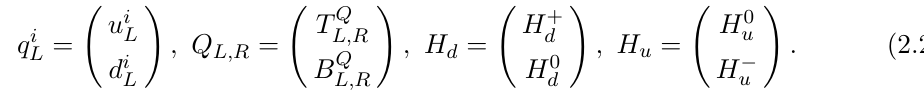
further assume that quarks couple to the two Higgs doublets as in the type-II model, namely the down sector couples to H and the up sector couples to H . This can be achieved by u d the Z symmetry speci(cid:12)ed in table 1. The generalization to the whole vectorlike family of 2 new fermions, including the lepton sector (which has been studied in ref. [37]), is